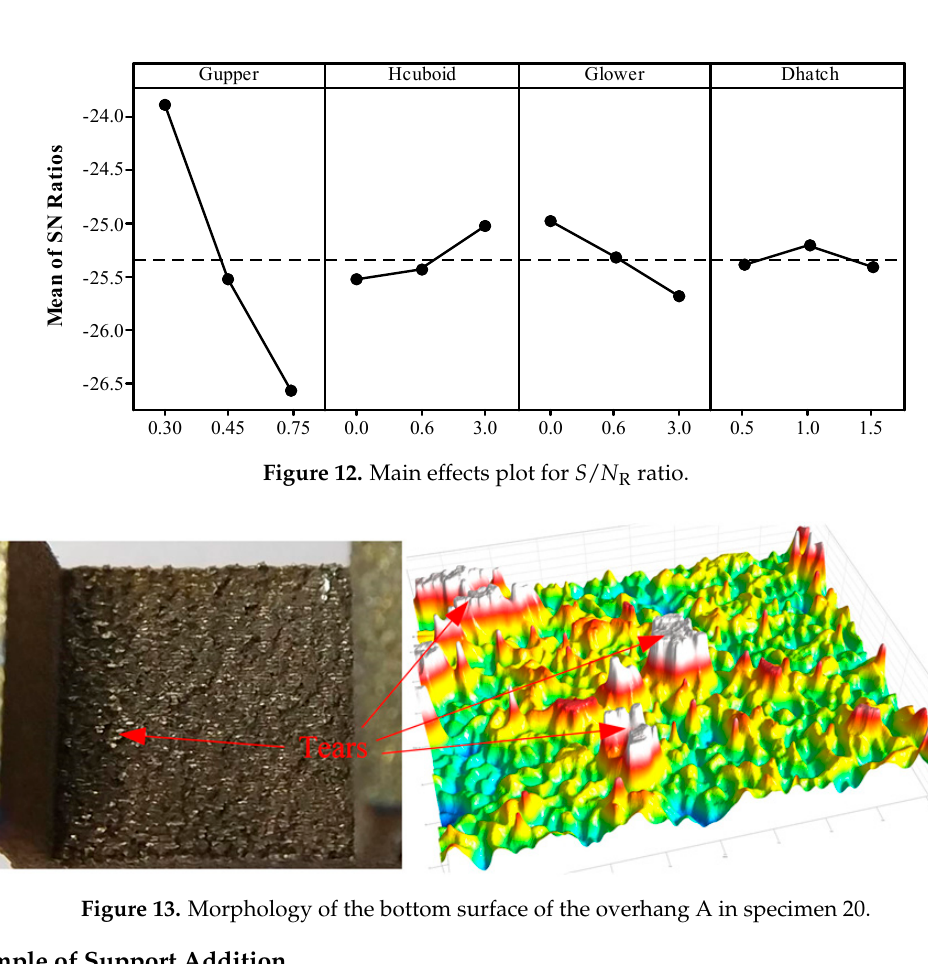
4 Table 8. ANOVA for Roughness ( R a ). R 2 = 73.0%. Source